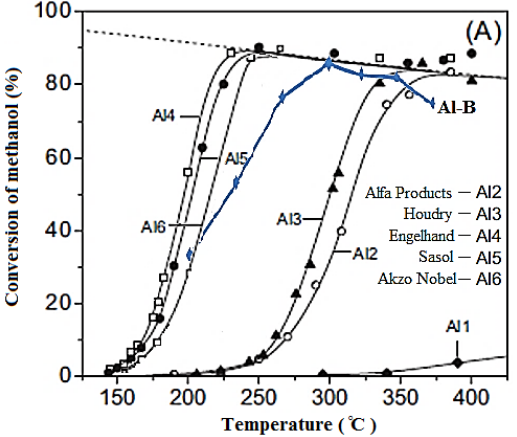
Fig. 10. Optimum conversion of methanol to DME over Al-B catalyst compared with commercial